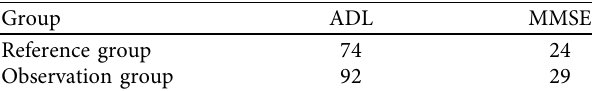
Figure 2: Visualization of cognitive function (%). Table 3: Comparison of the ADL scores and MMSE scores.